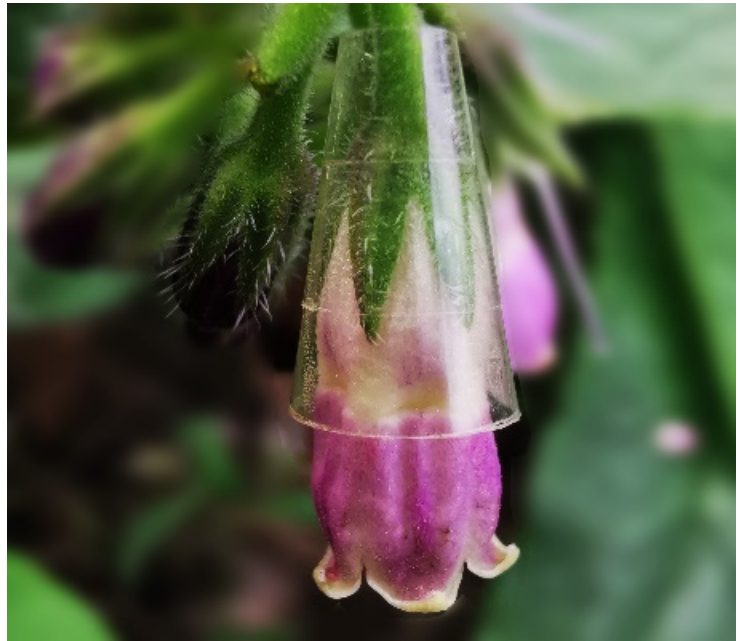
Figure 1. Flower of Symphytum officinale fitted at the base of corolla by a collar made of adhesive tape to prevent corolla from being pierced by nectar robbers.